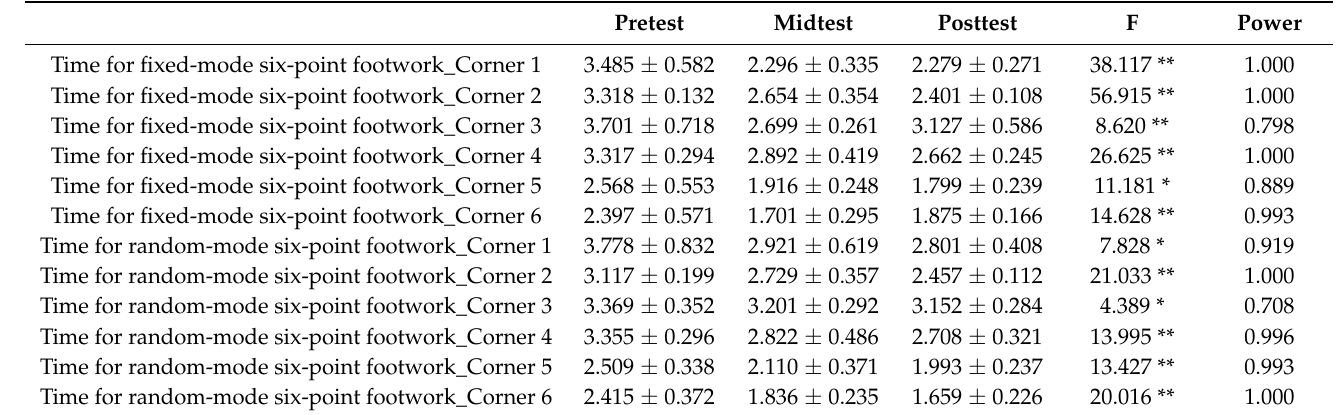
Table 3. Time taken for footwork movements in six-point positions in fixed and random modes.